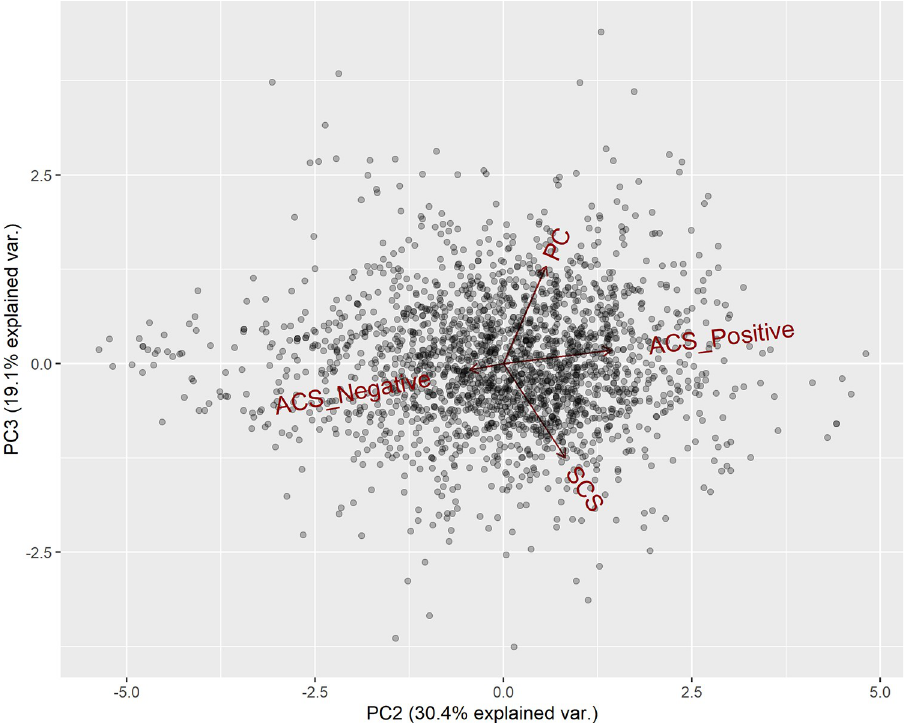
Fig 2. Biplot of principal component 2 and principal component